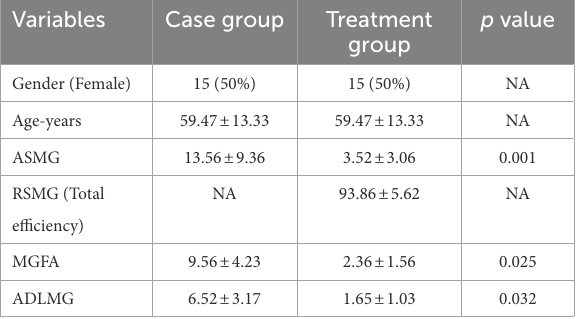
living of myasthenia